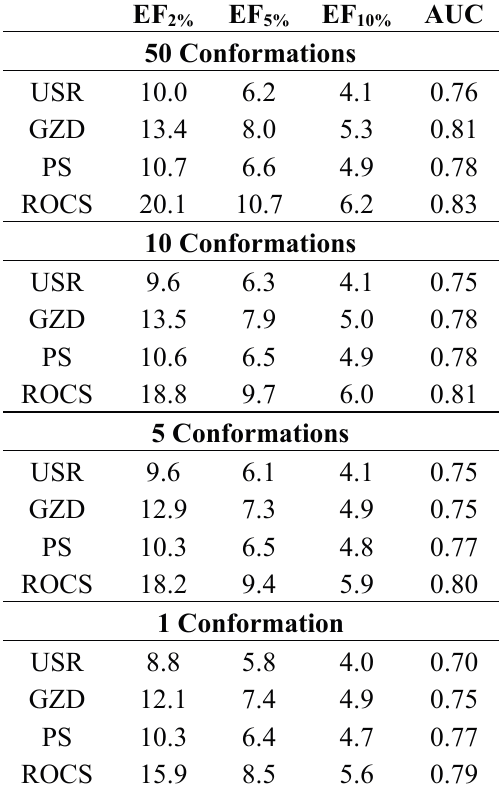
Table 1. Enrichment factors and area under the curve (AUC) values of the methods with different maximum numbers of conformations generated.